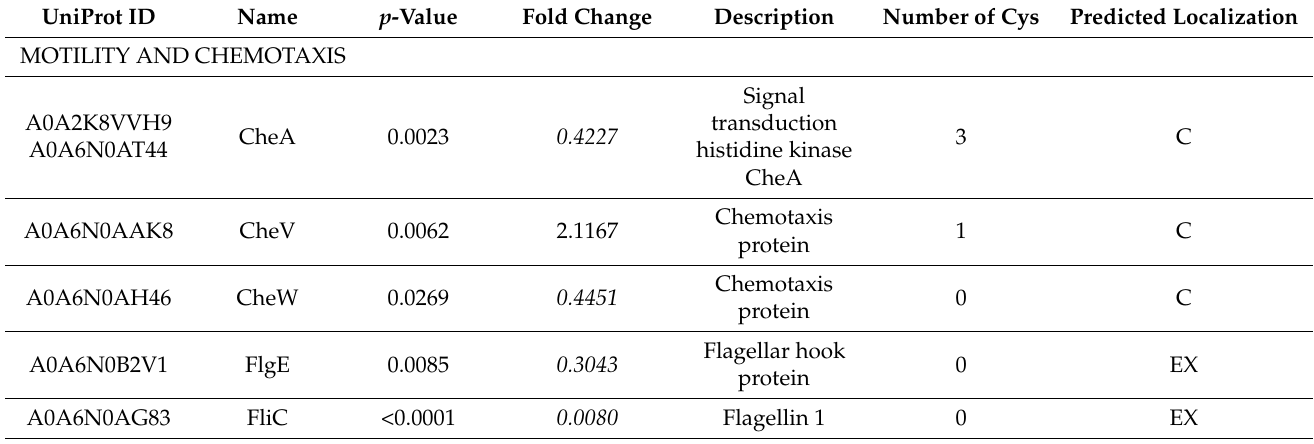
Table 1. Summary of proteins whose level depends on DsbA